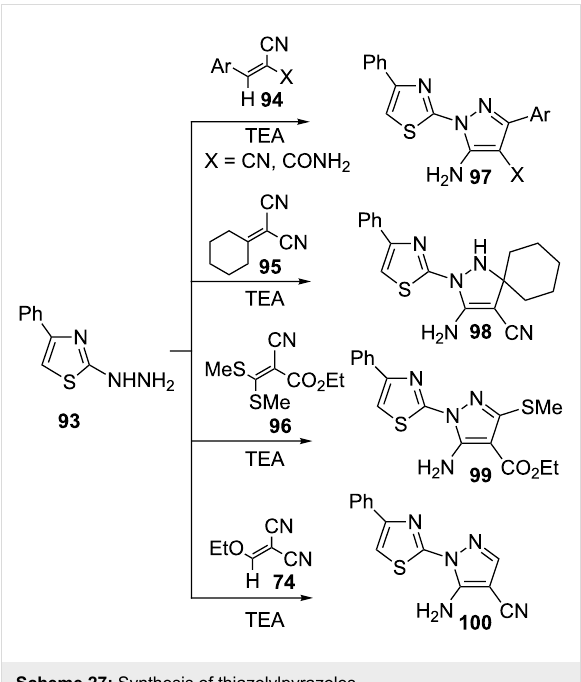
Scheme 27: Synthesis of